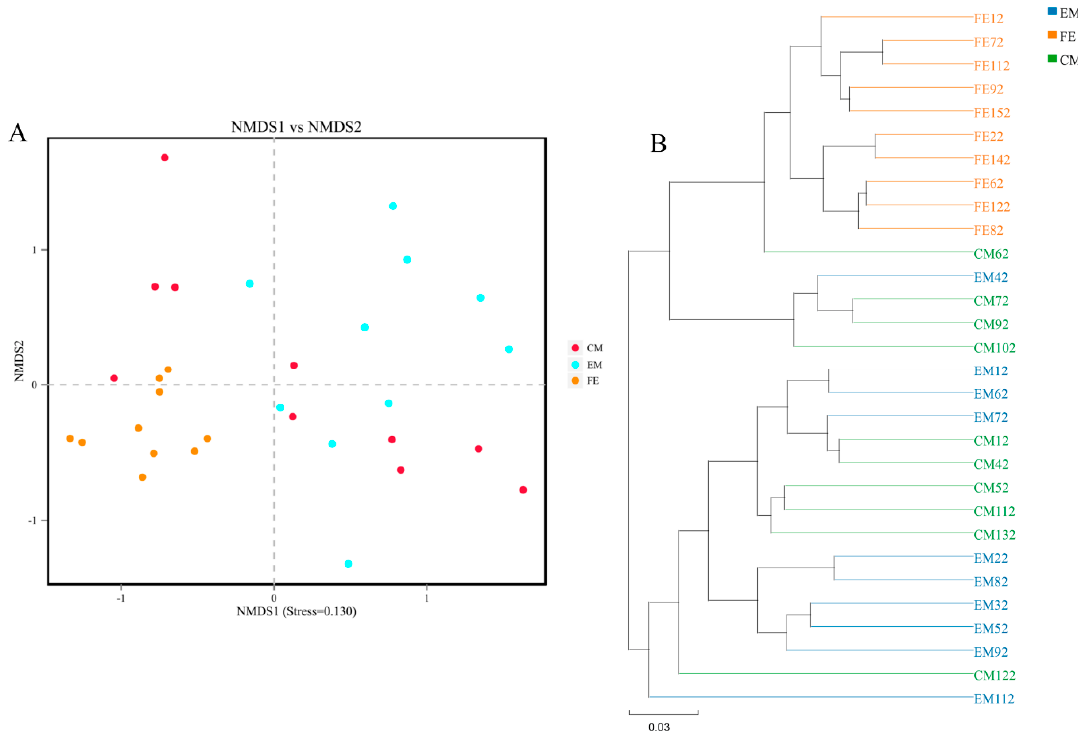
Figure 3. NMDS ordination ( A ) and UPGMA cluster ( B ).